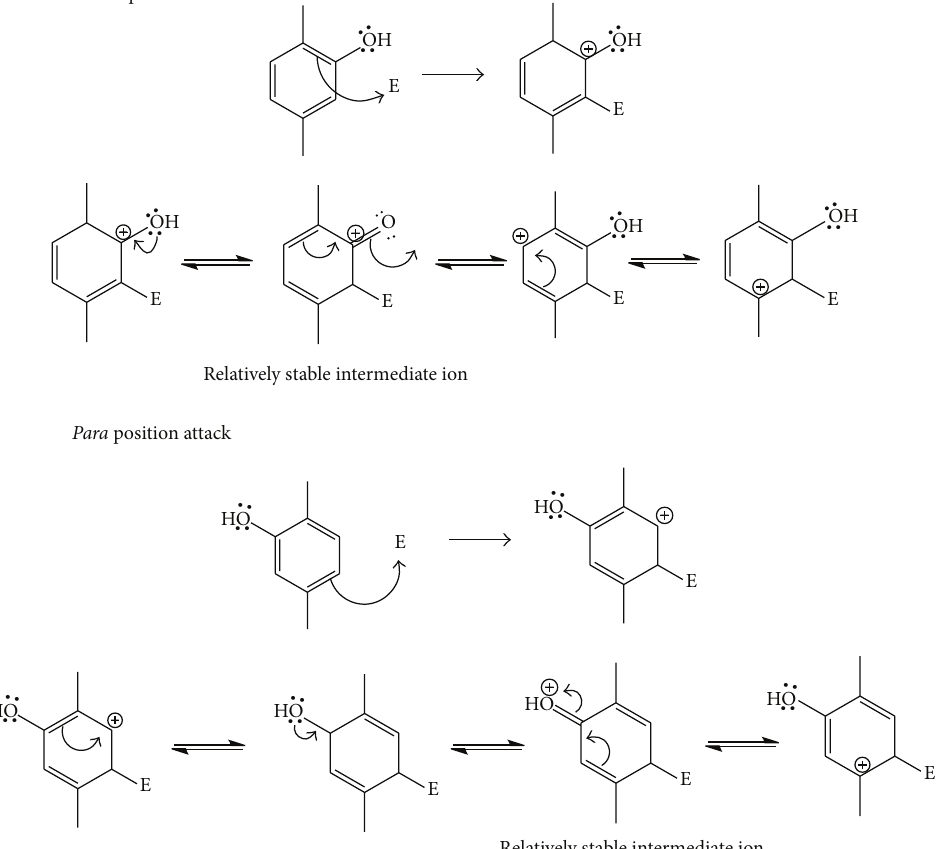
Scheme1:Resonancestructuresof ortho and para attacksinelectrophilicsubstitutionswithactivatorgroup,where“E”canbeanyelectrophile.